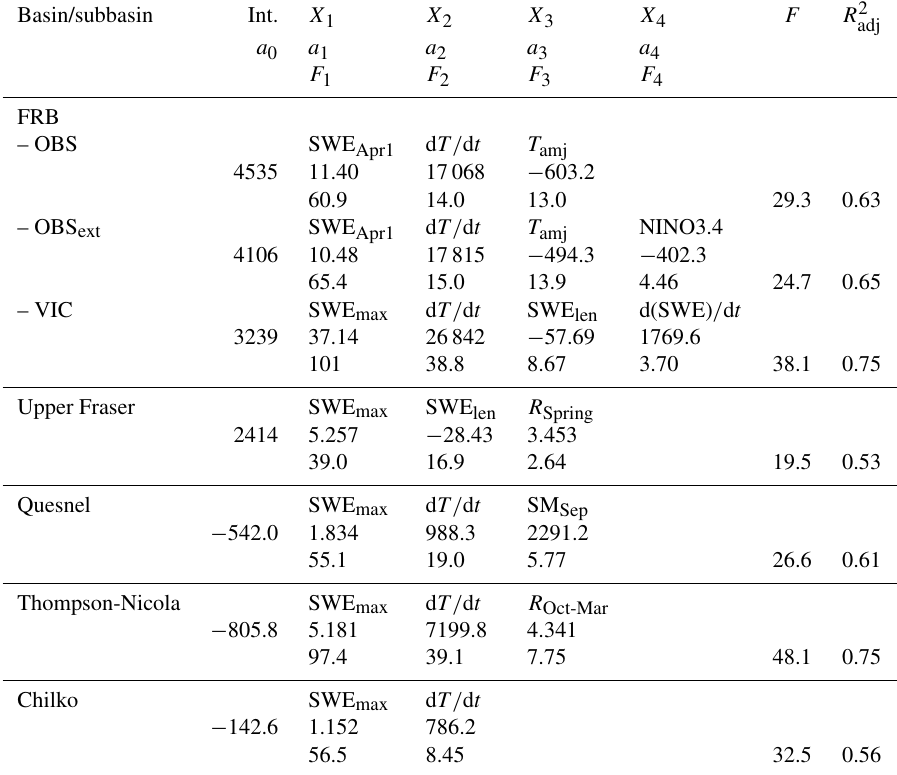
Table 4. Fitted parameters from multilinear regression of the form: Y = a 0 + a 1 X 1 + a 2 X 2 + a 3 X 3 + ... For each basin or subbasin, the first row in columns 2 to 6 indicates the relevant predictors, while the second and third rows list the fit coefficients and partial F -values, respectively (all partial p -values are less than 0.05). The total F -value and adjusted Pearson correlation for each fit is provided in columns 7 and 8, respectively. For the subbasins, only VIC results are given, due to the small number of 1 April observed SWE values available. Results given for OBS include basin-averaged predictors over the FRB, while those for OBS ext include indices of large-scale climate variability. Basin/subbasin Int. X